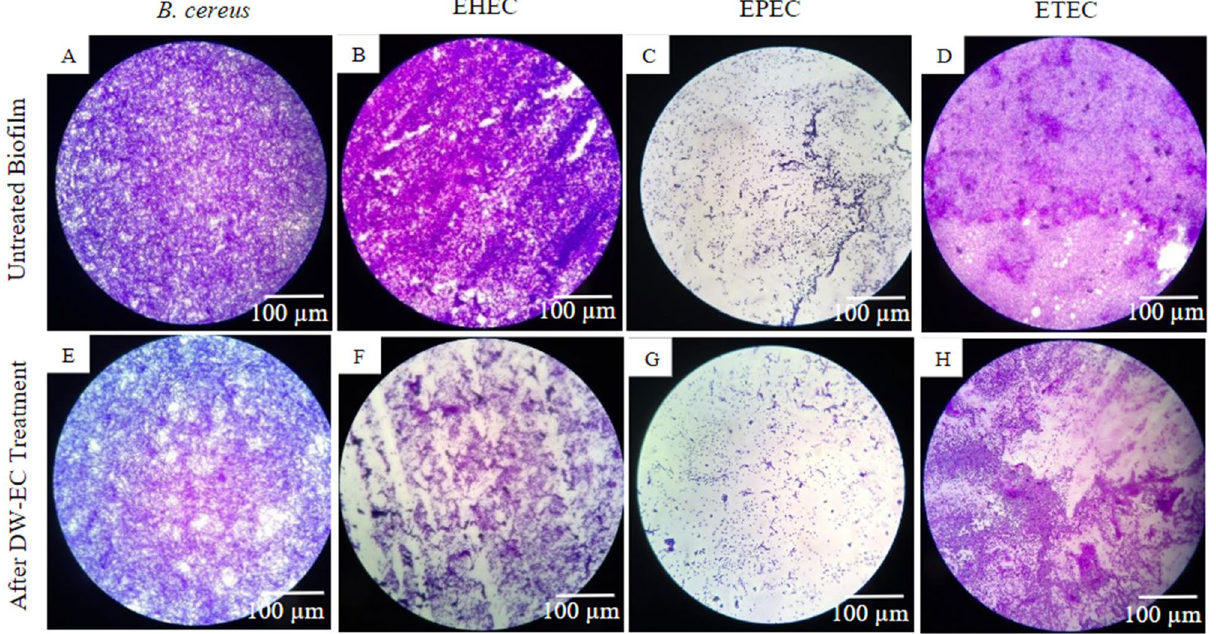
Figure 5. Destruction activity of bacteriophage DW-EC against biofilm formed by several pathogenic bacteria: ( A – D ) untreated biofilm and ( E – H ) biofilm treated with DW-EC. Magnification: 400×.